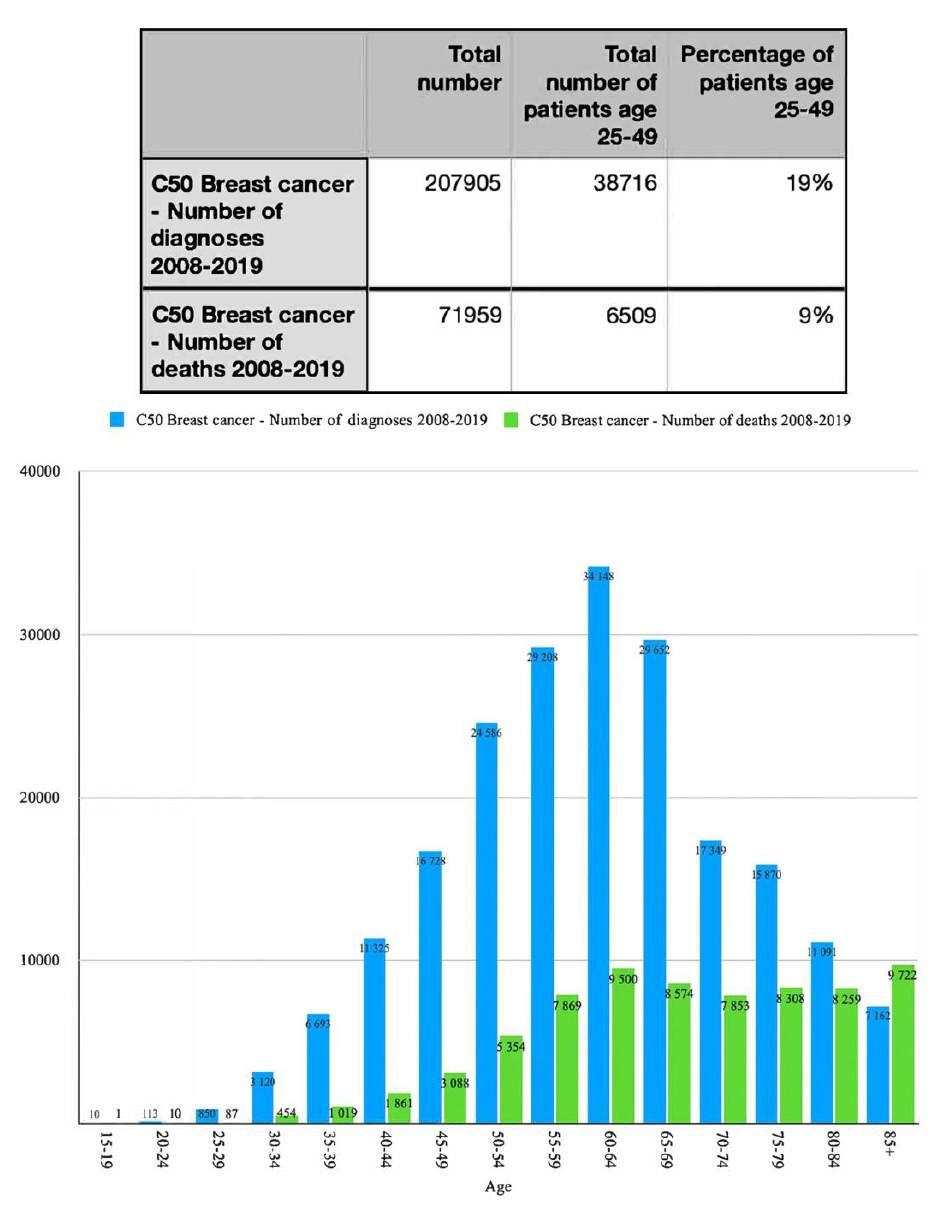
Figure 1. Number of breast cancer diagnoses and deaths between 2008 and 2019 in different age groups.